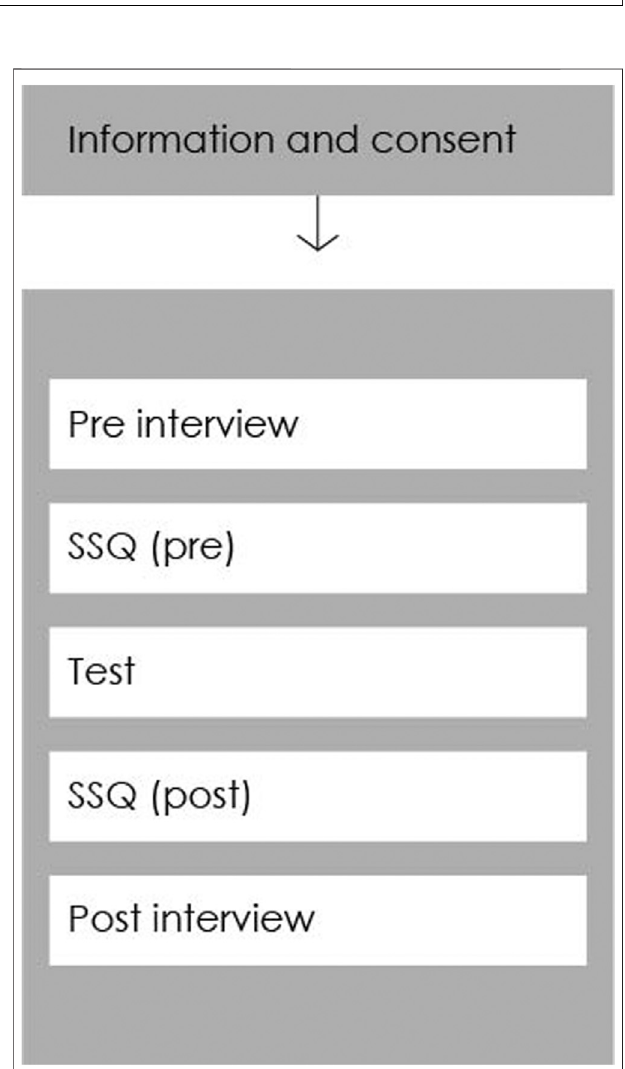
FIGURE 5 | Structure of the user test conducted with the home-based